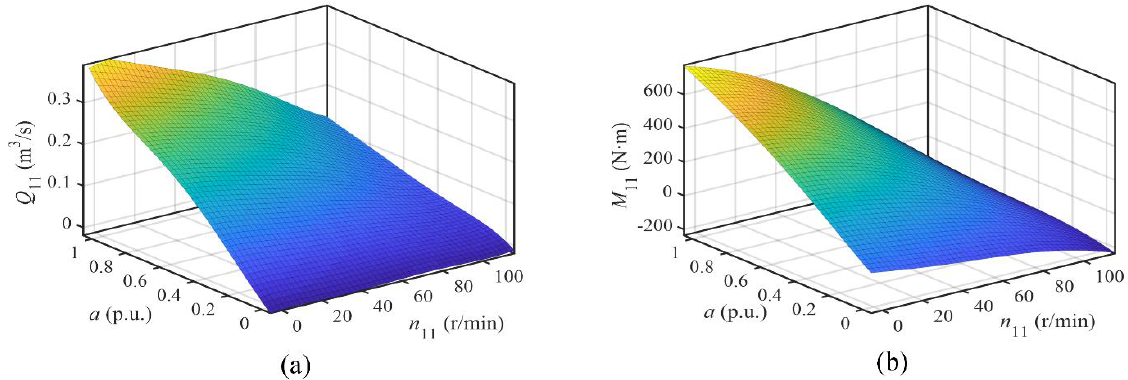
Figure 5. The characteristics of hydro-turbine. ( a ) The flow rate; ( b ) the torque.